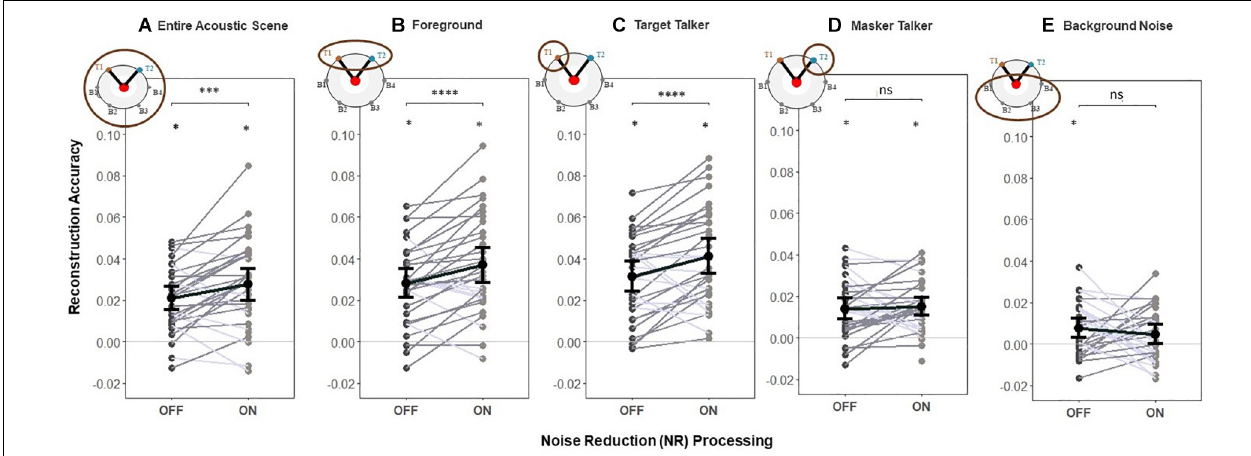
FIGURE 4 | Reconstruction accuracy for early responses (0–85 ms). (H1) The NR scheme enhances the representation of the entire acoustic scene, foreground and target in early EEG responses. A significant main effect of NR scheme setting was observed, indicating the enhanced neural representations of the entire acoustic scene, foreground and target envelopes in early EEG responses when NR scheme was active. For the masker talker and background noise, results indicate no significant difference in reconstruction accuracy between NR scheme settings. Shaded dots indicate trial-averaged individual reconstruction accuracy results (individual level), whereas black dots and error bars show the group (grand-average ± 1 between subject SEM) level reconstruction accuracy results using decoders trained only on (A) entire acoustic scene envelope (entire acoustic scene decoder), (B) foreground envelope (foreground decoder), (C) target envelope (target decoder), (D) masker envelope (masker decoder), and (E) background noise envelope (background noise decoder). Each shaded dot represents the reconstruction accuracy of the envelopes for a single participant (i.e., the reconstruction accuracy values averaged over 20 trials), each line in gray denotes single participant (dark gray denotes enhanced reconstruction accuracy and light gray denotes reduced reconstruction accuracy when activating NR scheme) and each line in black denotes average reconstruction accuracy across participants for each envelope type. The asterisk above each condition indicates reconstruction performance significantly greater than zero (determined with a two-sided t -test with criterion p = 0 . 05). The asterisk above the bars indicates significant differences between the NR conditions (* p = 0.05, ** p = 0.01, *** p = 0.005, and **** p =